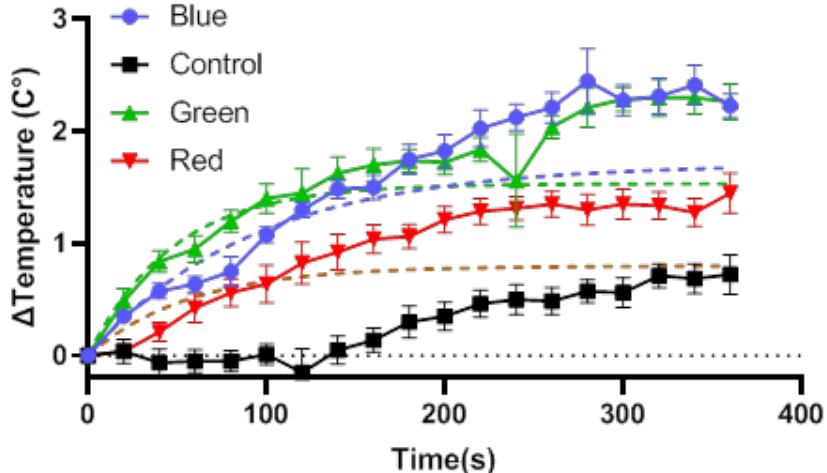
Figure 9. Mean wound surface temperature readings throughout the therapy session taken at 20 s intervals with error bars showing SEM. Dashed lines indicate the exponential plateau regression fit of irradiative warming when colors are corrected for control group kinetic temperature increase.